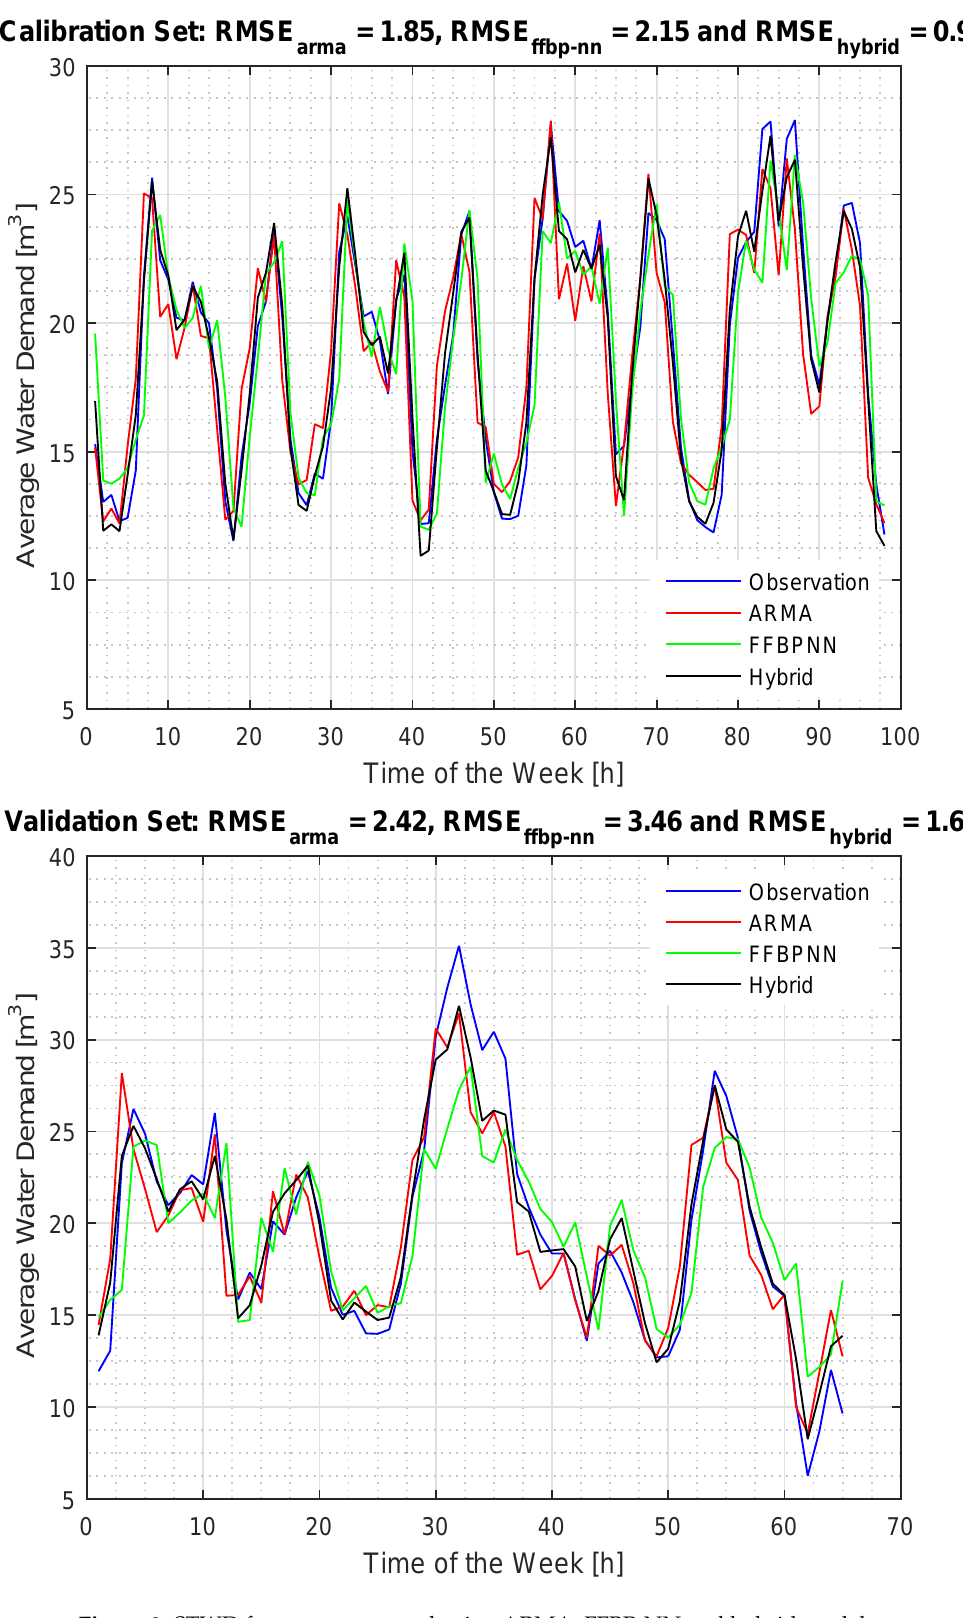
Figure 2. STWD forecasts generated using ARMA, FFBP-NN and hybrid